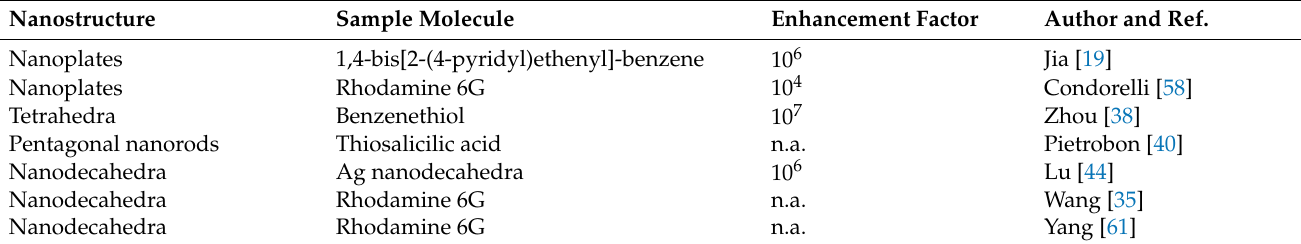
Table 1. Summary of SERS reports from photochemically synthesized Ag